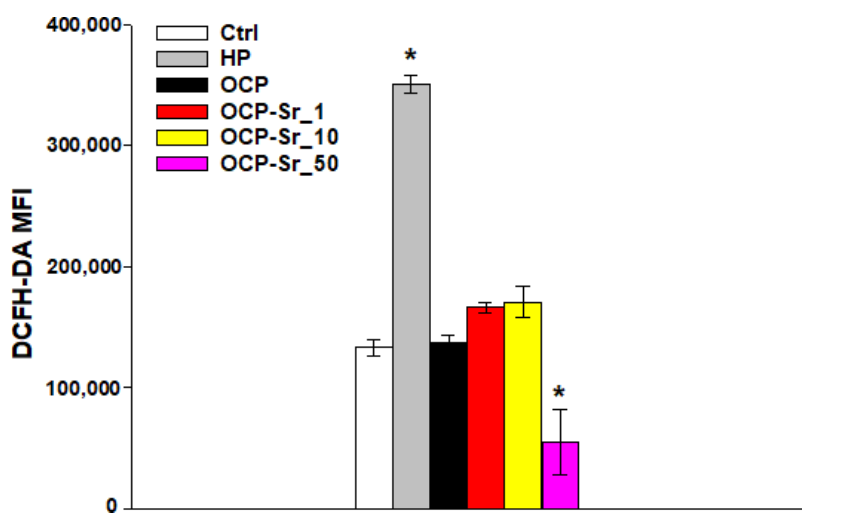
Figure 8. Production of reactive oxygen species (ROS) in C 3 H/10T1/2 cells after 96 h of incubation with OCP and OCP-Sr. Ctrl—untreated cells without the addition of calcium phosphate compounds. HP—hydrogen peroxide. MFI—Mean fluoresce intensity. *—statistically significant difference, compared with control cells, p < 0.05.